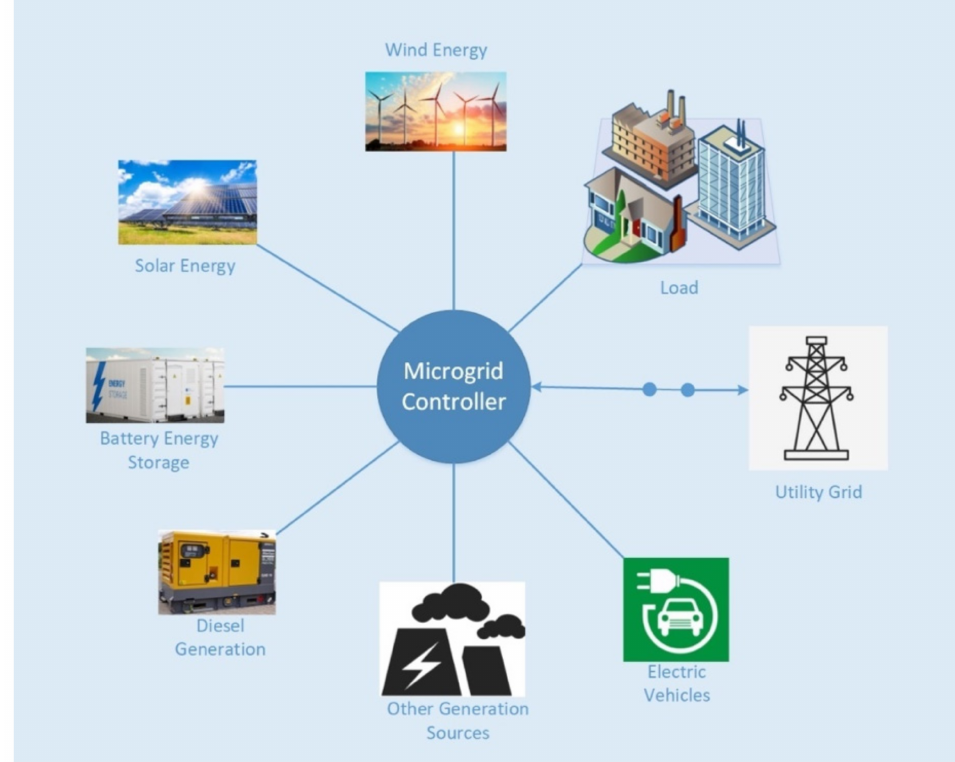
Figure 2. Microgrid